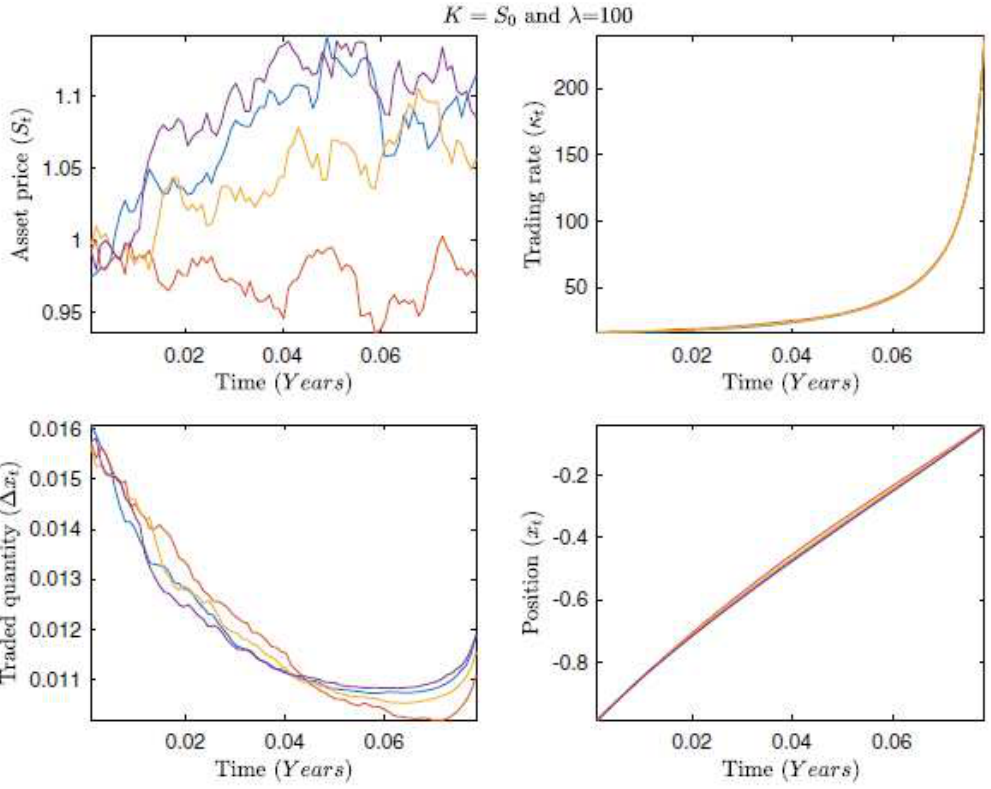
Fig. 8. Sample paths of the evolution of the fundamental price, trading rate, inventory and traded quantity throughout the execution for (cid:540) =